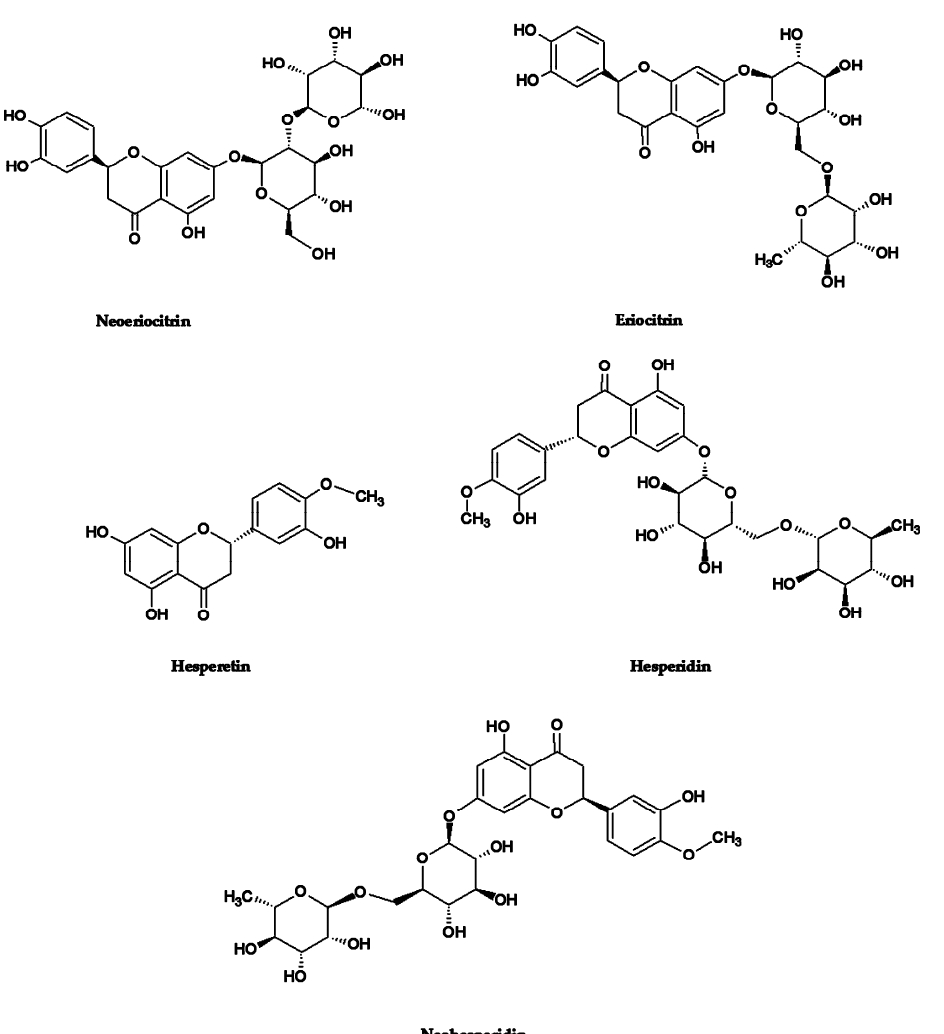
Figure 1. Chemical structures of the selected most powerful Citrus flavanones. The antioxidant screening was carried out using four different colorimetric tests (ORAC, FRAP, TEAC, and DPPH) characterized by different environments and reaction mechanisms, as well as by different charged radicals. Results were depicted in Figure 2, which reports the IC 50 of the five strongest flavanones (neohesperidin, hesperidin, neoeri- ocitrin, eriocitrin, and hesperetin) in comparison with the reference standard trolox.